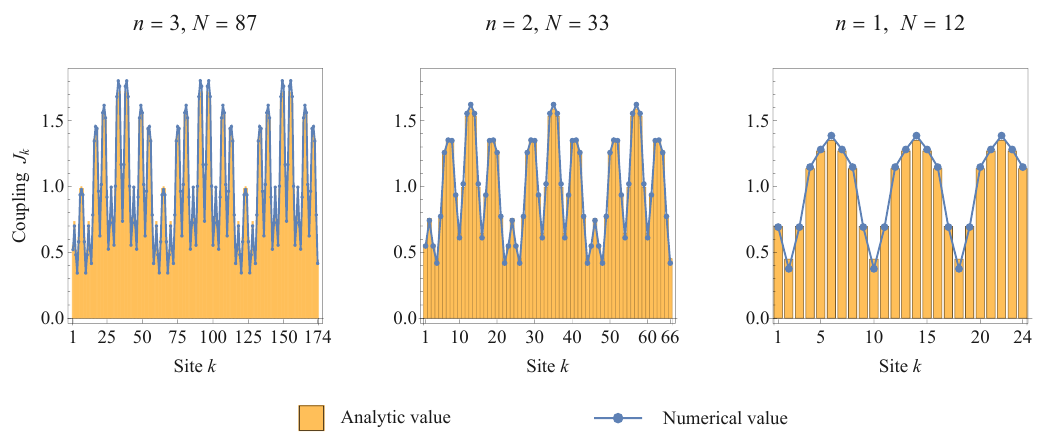
Figure 16 . Coupling terms { J k } of the parent Hamiltonian (3.8) for the { 3 , 7 } MTN ground state, obtained analytically as in (3.5) from the disorder vector g (orange bars) and numerically through the optimization of a nearest-neighbor Hamiltonian (blue points). Both couplings closely match for systems of different size N at various inflation steps. The couplings are normalized so that P 1 J k = 1 k 2 N